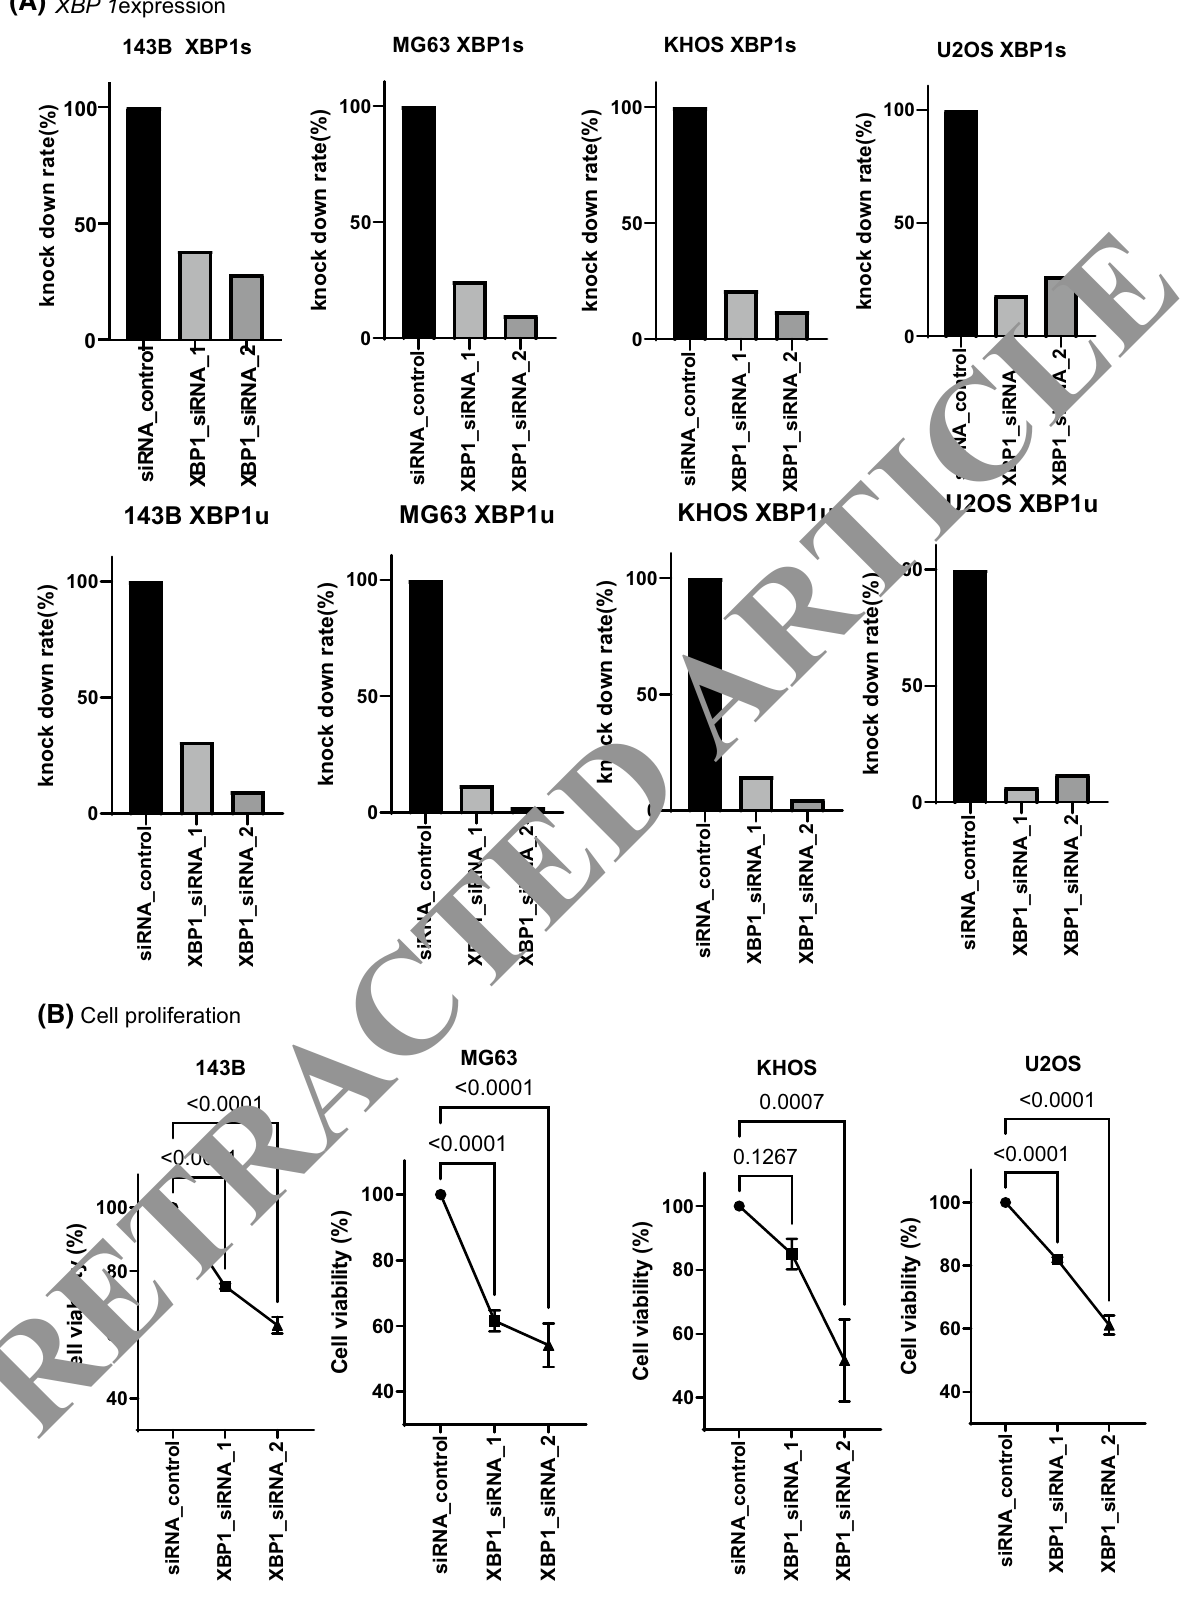
Fig. 4 Cell viability by XBP1 knockdown in OS cell lines. A The expression of XBP1s and XBP1u in all OS cell lines is suppressed by all XBP1 siRNAs. B The cell viability in all OS cell lines is significantly inhibited due to XBP1 silencing by siRNA